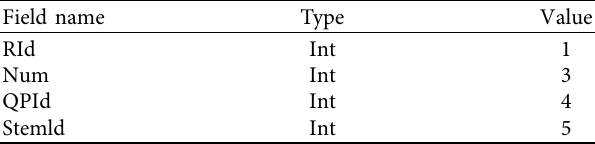
Table 1: Data table of test